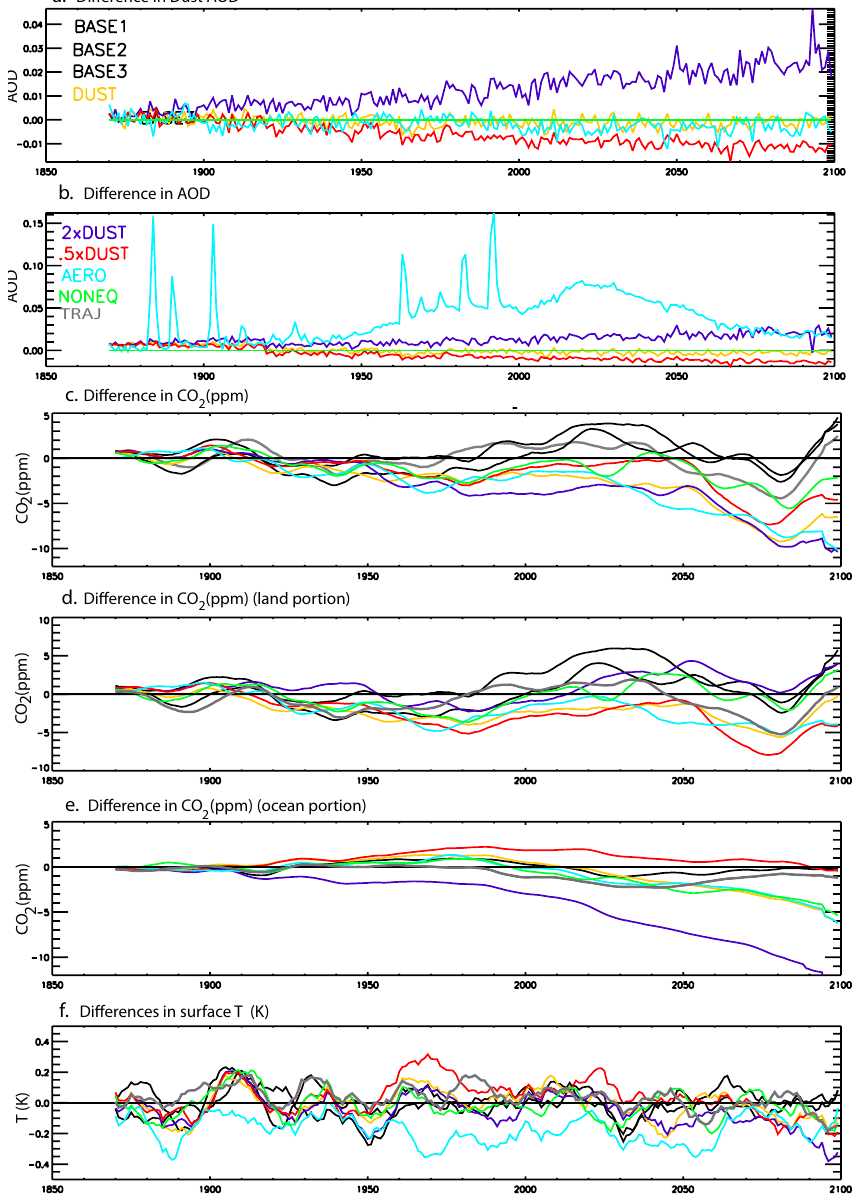
Fig. 3. Globally averaged time series for each case for the difference between each case and BASE1 for (a) dust aerosol optical depth, (b) total aerosol optical depth, (c) CO 2 concentration (ppm) (the sum of d and e ), (d) CO 2 concentration contribution from land (ppm), (e) CO 2 concentration contribution from ocean (ppm) and (f) surface temperature